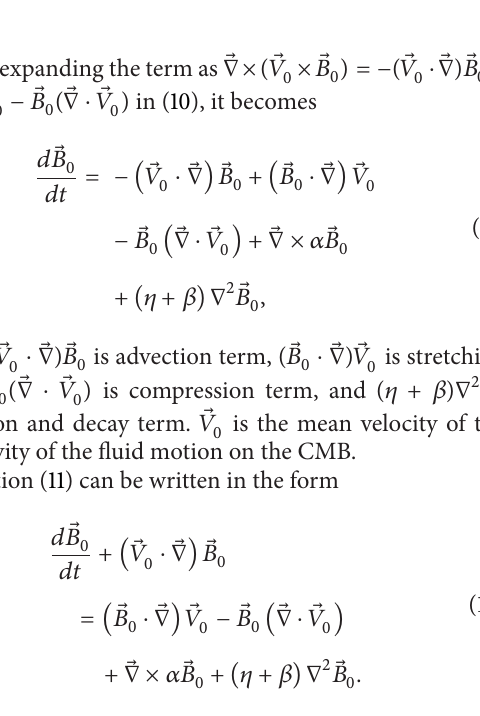
Figure 1: The locations of the observatories in North